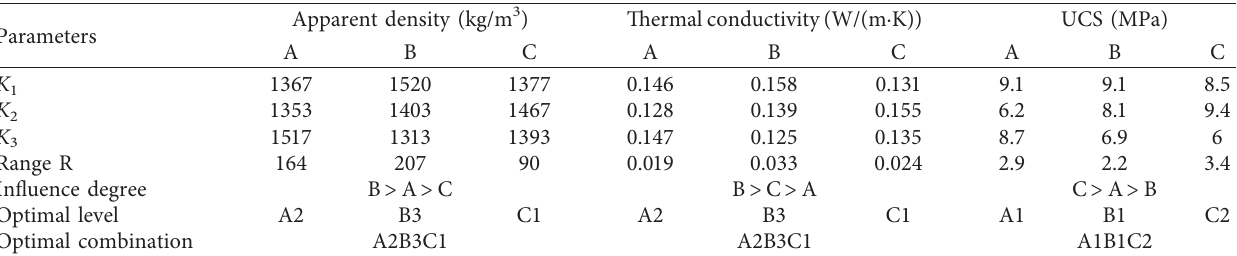
Table 4: Range analysis